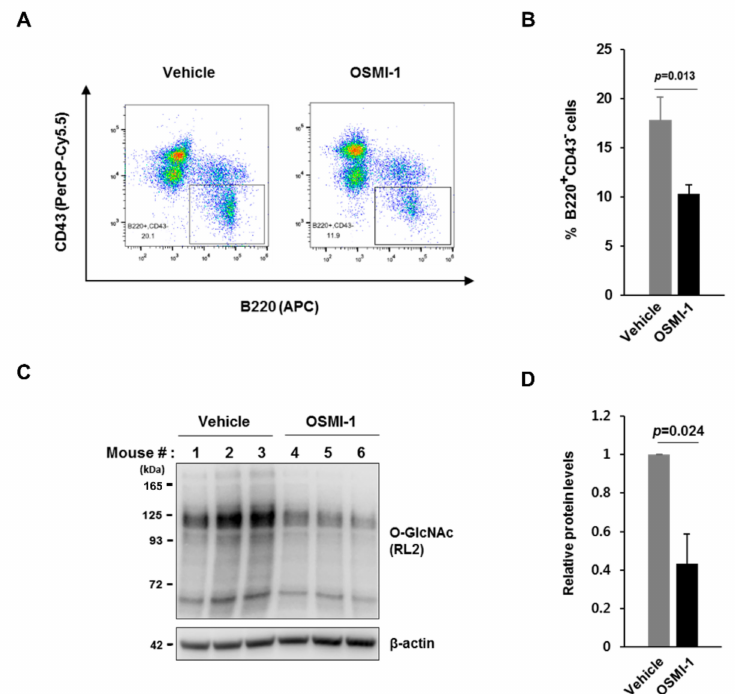
Figure 7. The population of B cells after the pro-B cell stage in the bone marrow is markedly reduced by administration of an OGT inhibitor to mice. ( A ) Representative plot of the flow cytometric analysis data, including PerCP-Cy5.5-CD43 and APC-B220 staining of total bone marrow (BM) cells from mice at 7 days after daily injection of OSMI-1 or a vehicle control. ( B ) Quantification of the percentage of B220 + CD43 − cells from ( A ). Data are represented as mean ± SD ( n = 3). Comparison of OSMI-1 treatment with the vehicle control. ( C ) Western blot analysis of changes in O-GlcNAcylation in BM cells from mice at 7 days after daily injection of OSMI-1 or the vehicle control. ( D ) Quantification of relative protein levels according to western blot results from ( C ). Data are represented as mean ± SD ( n = 3) normalized using β -actin as a loading control. Comparison of OSMI-1 treatment with the vehicle